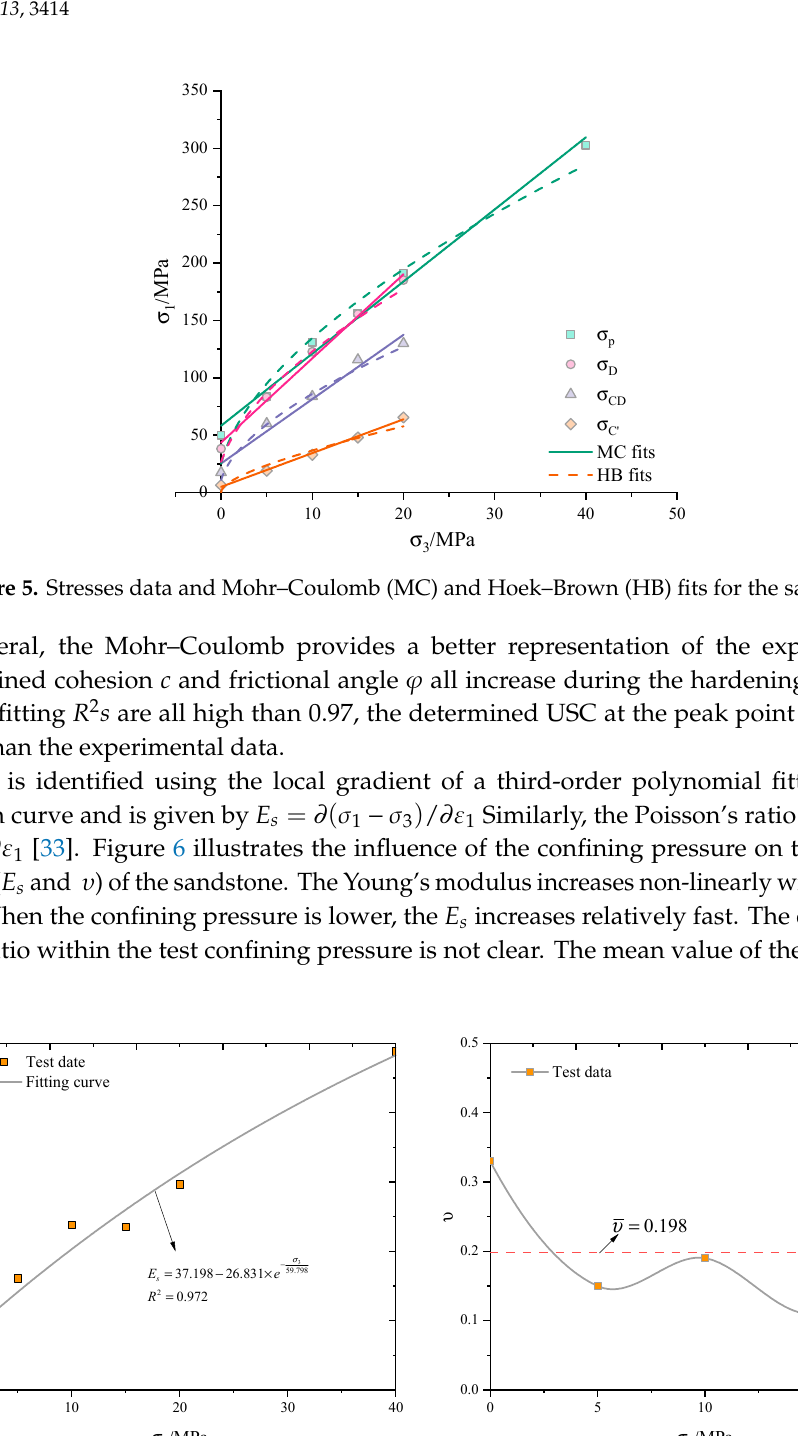
Figure 6. Influence of confining pressure on ( a ) Young’s modulus and ( b ) Poisson’s ratio of sandstone.